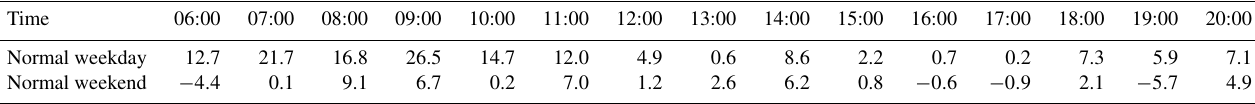
Table 5. Daytime percentage difference of NO x compared to national holiday case.